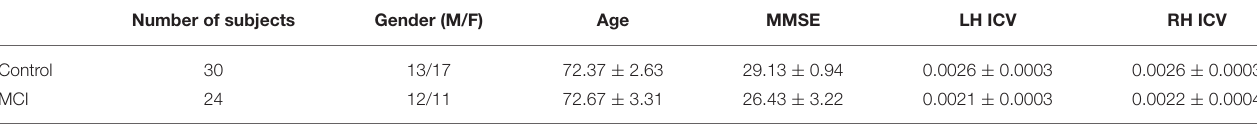
TABLE 1 | Mean ± standard deviation of the demographic characteristics of controls and